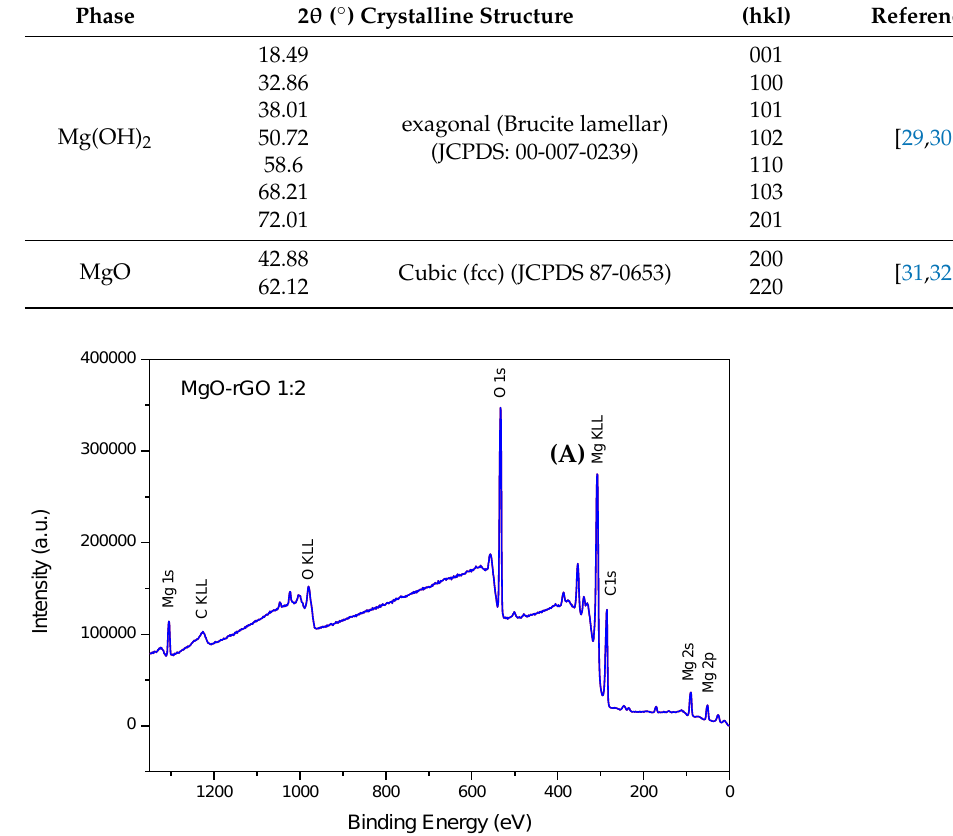
Table 1. XRD peak identification of MgO–rGO nanocomposite. Phase 2 θ ( ◦ ) Crystalline Structure